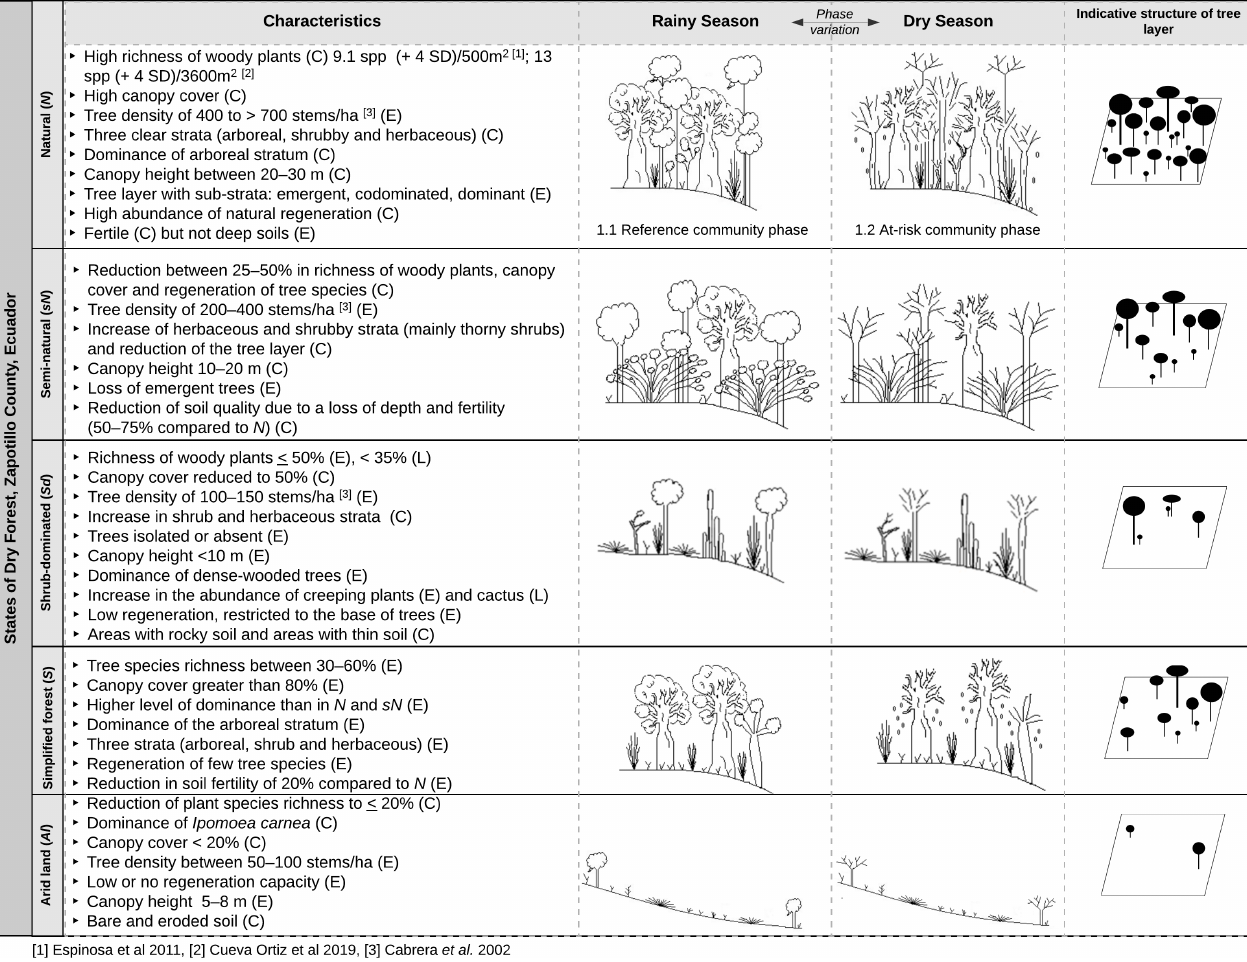
Fig. 2. Forest states of the Zapotillo dry forest ecological site, with variation between the dry and rainy season. State descriptions include vegetation structure, natural regeneration, and soil characteristics. The letters in parentheses indicate the group of stakeholders that mentioned each characteristic: E = ecologists, L = locals, and C = consensus between both